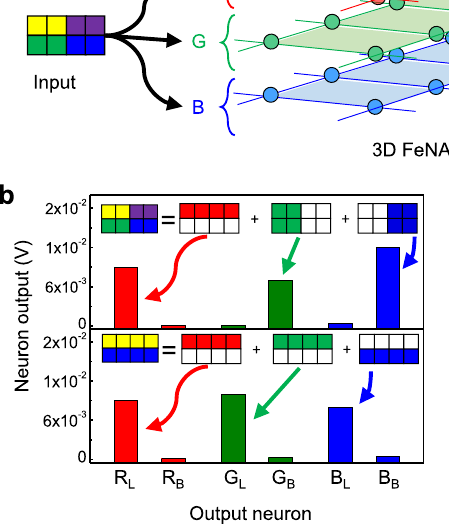
mixedpatternclassi fi cationusing3DFeNAND-basedneuralnetwork.TheR L ,R B ,G L , G B , B L , and B B stands for the red line, red box, green line, green box, blue line, and blue box, respectively. For the mixed pattern containing the red line, green box, and blue box, only the corresponding output neurons showed high neuron out- puts. c Classi fi cation result for 20 input patterns. The summed neuron output showed high output only for the correct